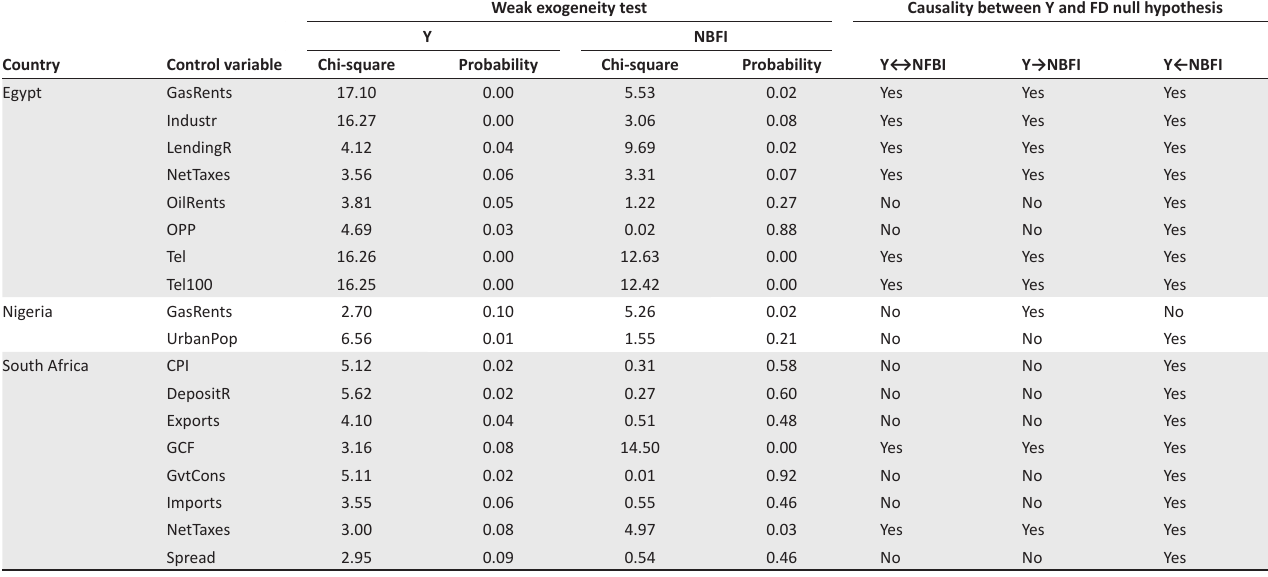
Weak exogeneity